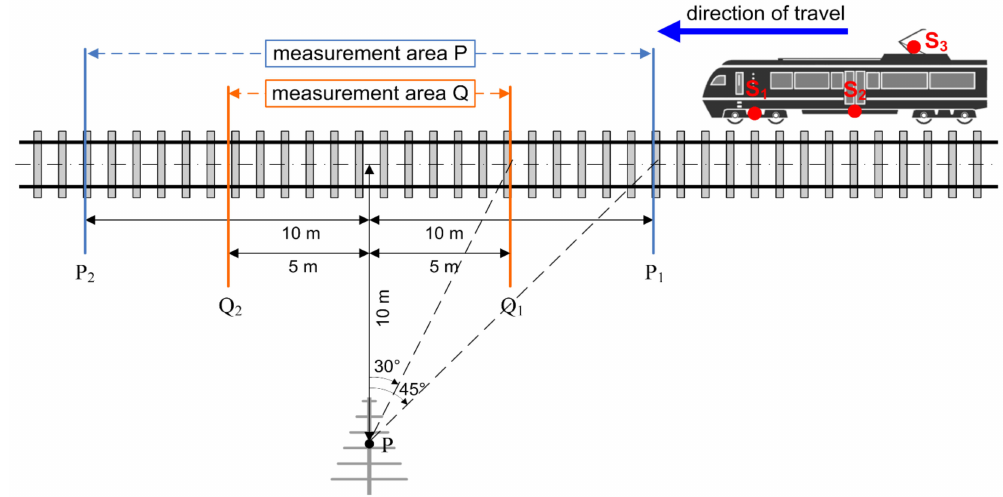
Figure 4. Sketch of the measurement area with passage points “1” and “2”, where the instrument scan is to be started and stopped (in line with EN 50121-3-1): the measurement area defined by P 1 and P 2 is related to a ± 45 ◦ angle, the area defined by Q 1 and Q 2 ± 30 ◦ . The presence of the rolling stock should be accounted for the likely positions of the sources: S 1 (motor cables), S 2 (static power converters), and S 3